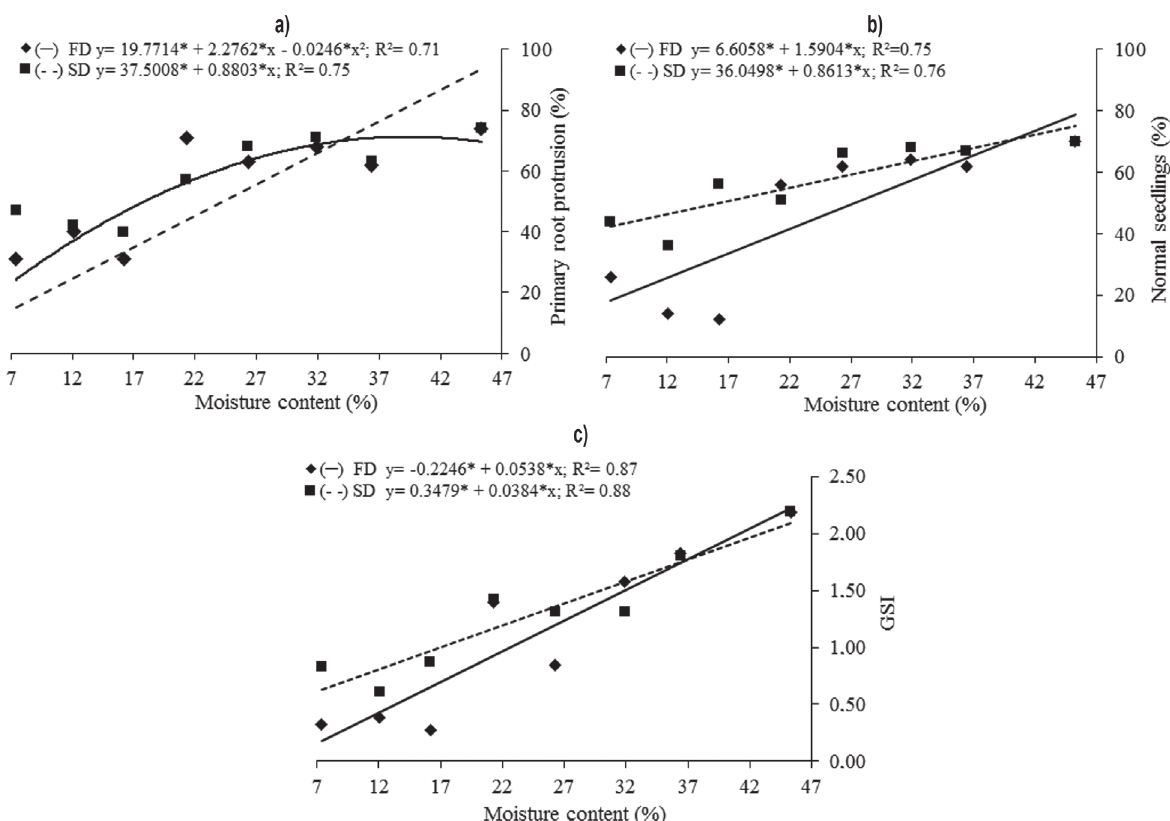
Figure 2 - Effect of drying rate on primary root protrusion (a) , percentage of normal seedlings (%) (b) and germination speed index (GSI) (c) of Campomanesia adamantium seeds subjected to fast drying (FD) (silica) and slow drying (SD) (room temperature) at different water